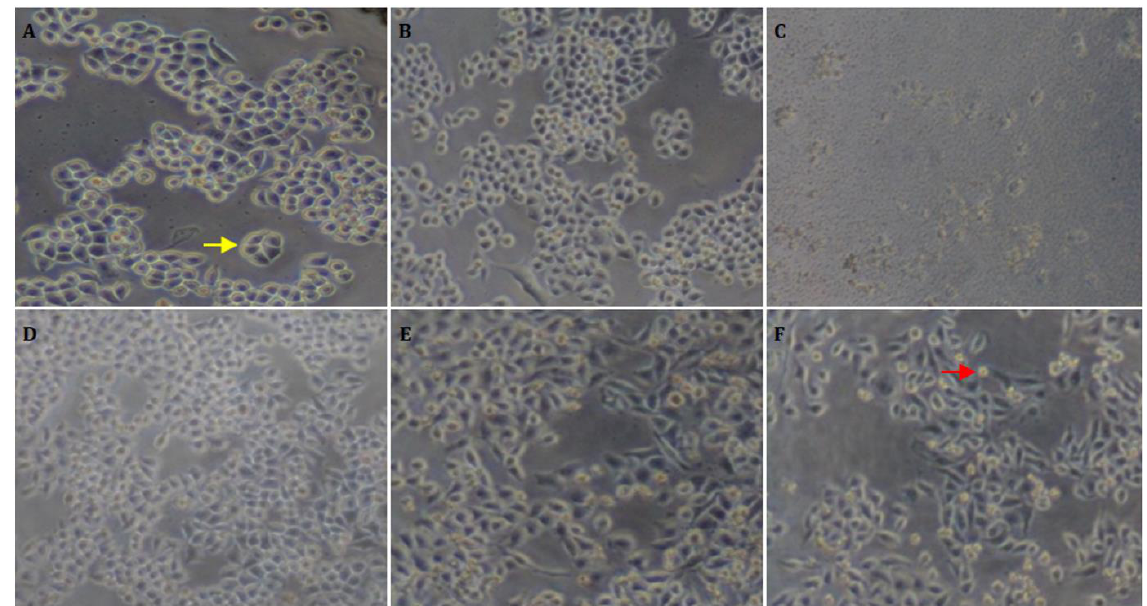
Figure 1. Morphology of WiDr cells after treated with extracts. (A) Control WiDr cells in 24h incubation. (B) Treatment of red ginger extract at 15µg/mL for 24h. (C) Treatment of red ginger extract at 500 µg/mL for 24h. (D) Control WiDr cells in 48h incubation. (E) Treatment of red ginger extract at 15 µg/mL for 48h. (F) Treatment of red ginger extract at 500 µg/mL for 48h. Photographs were taken at 10x magnification. Yellow arrow showed viable cells, while red arrow showed death cells.